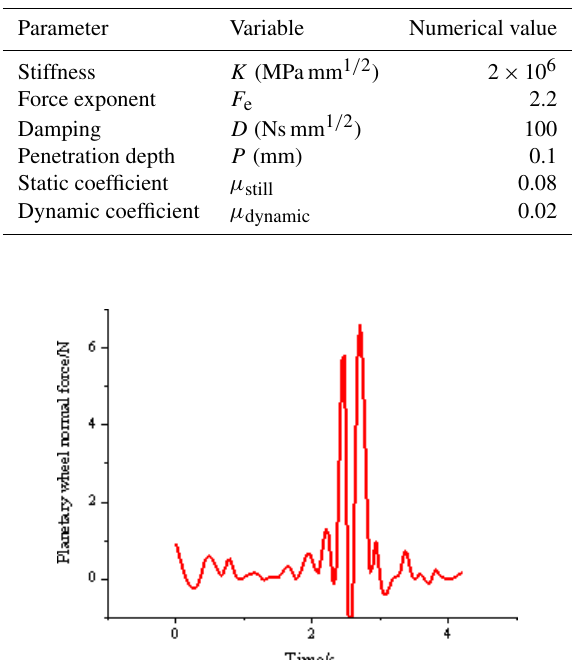
Table 7. Contact force parameter.